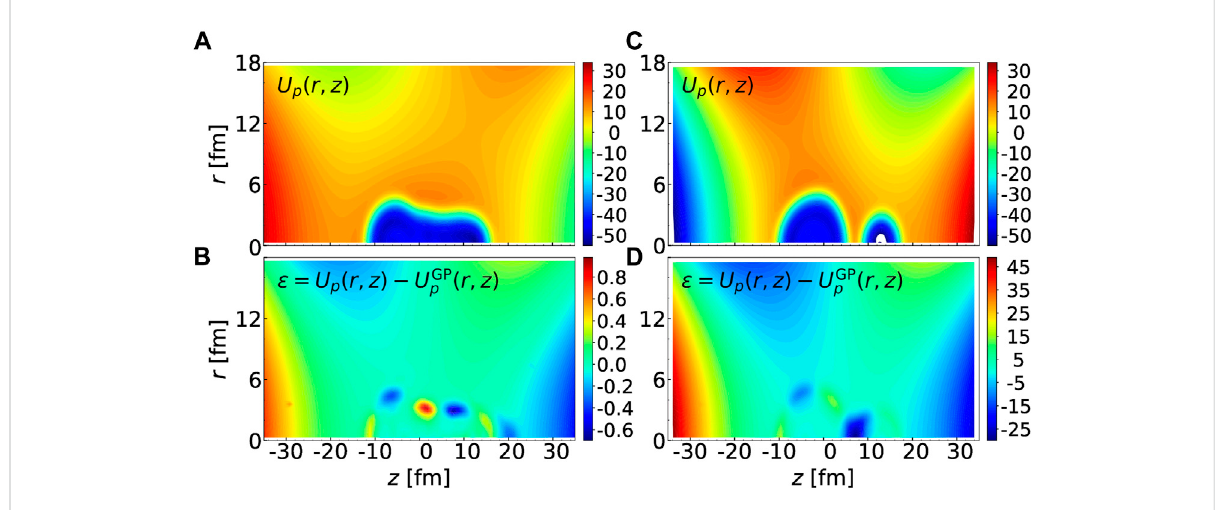
FIGURE 4 (A) : Central part of the mean- fi eld potential for protons, U p ( r , z ) for the con fi guration ( q 20 , q 30 ) = (198 b, 30 b 3/2 ); (B) : Error in the GP fi t for that same con fi guration. (C) :Central part of themean- fi eld potential for protons, U p ( r , z ) for the con fi guration ( q 20 , q 30 )= (138 b, 51 b 3/2 ); (D) : Error inthe GP fi t for that same con fi guration. In all fi gures, the energy given by the error bar is in MeV. Note the much smaller energy scale for the bottom left